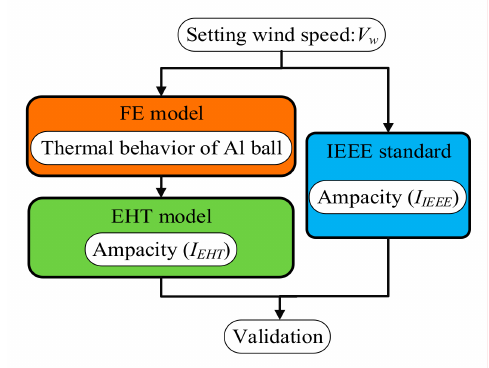
Figure 8. Validation process of EHT model.